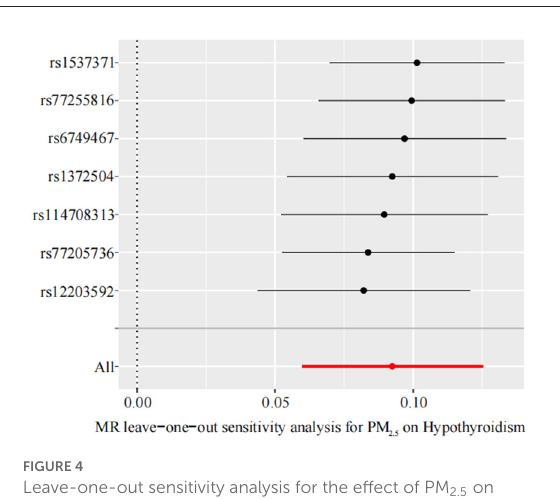
FIGURE4 Leave-one-out sensitivity analysis for the effect of PM 2.5 on hypothyroidism. The x-axis shows MR leave-one-out sensitivity analysis for PM 2.5 on hypothyroidism. The y-axis shows the analysis for the effect of leave-one-out of SNPs on hypothyroidism. MR, Mendelian randomization; PM 2.5 , particulate matter 2.5; SNP, single nucleotide